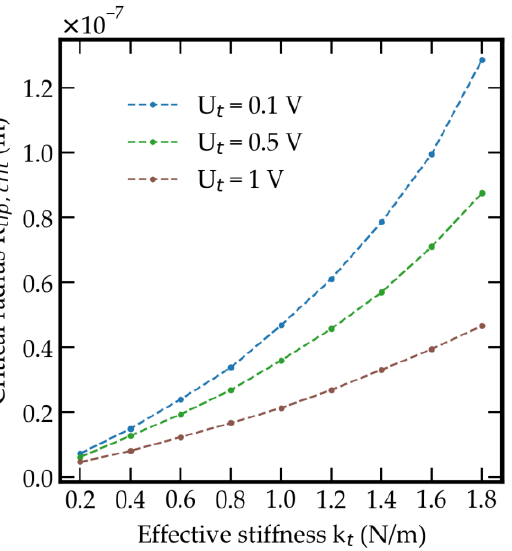
Figure 5. Effective stiffness k t vs. critical radius of R tip , crit at different tunneling bias voltage U t to reach an effective tunneling distance of 10 Å .